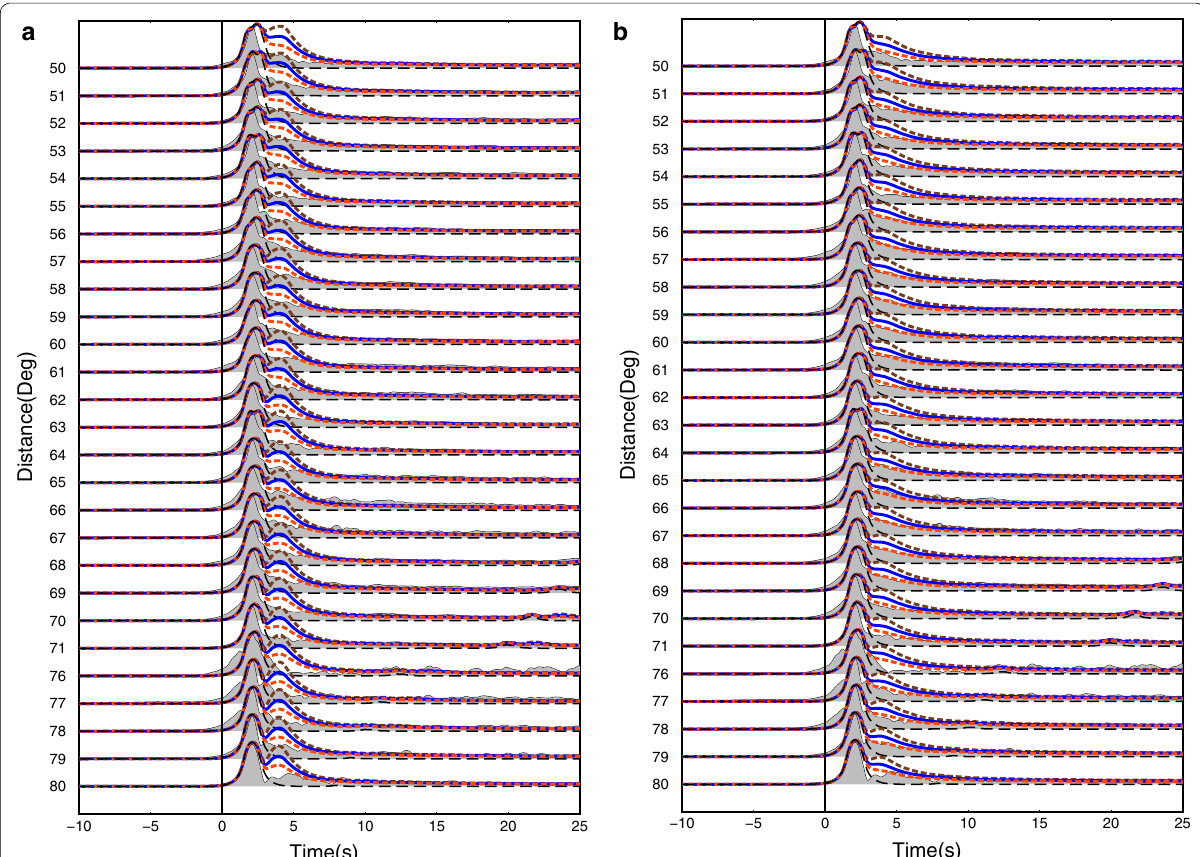
Fig. 10 Comparisons of synthetics for two scattering models with different frequency values ( f ). The blue lines represent synthetics with f while red and brown dashed lines represent synthetics with f and a 1.4 km. b The whole lithospheric scattering model with σ =